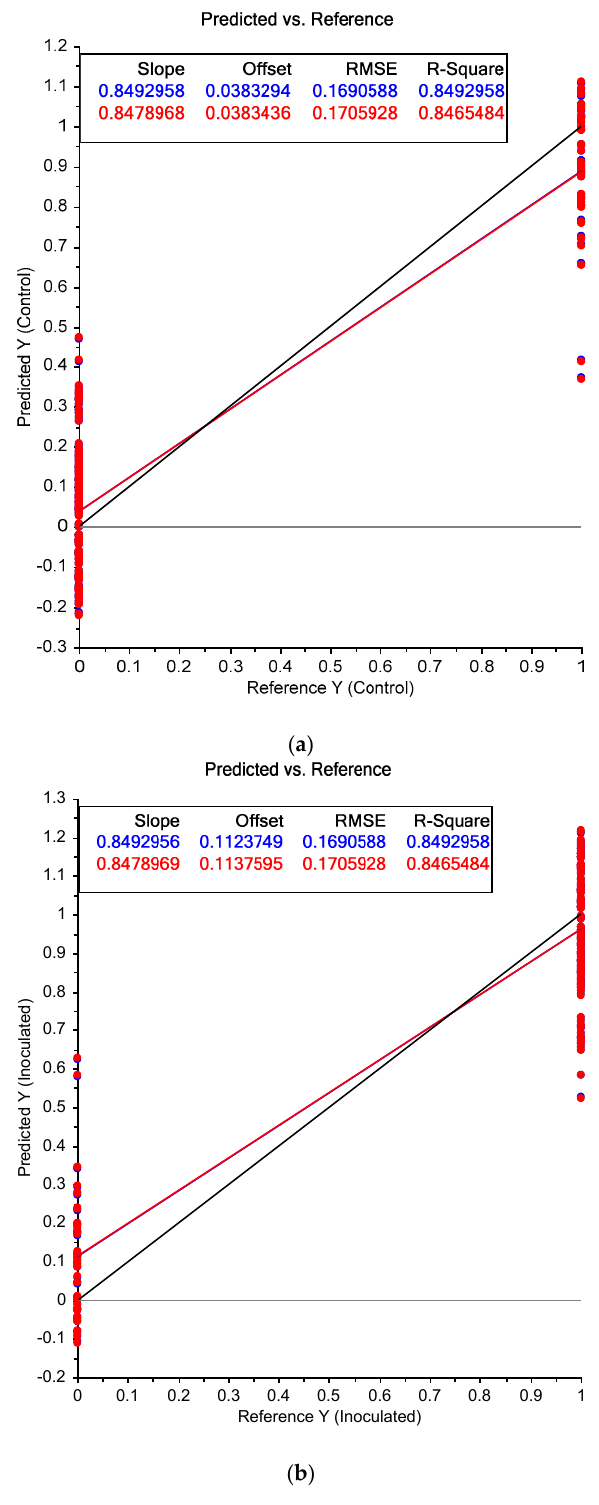
Figure 7. Regression plots for model using 2189 nm wavelength for ( a ) control and ( b ) inoculated samples at milk, dough and dent stages of maturity (with offset for control samples closer to target line) for categorical classification into control and inoculated sample groups. Red font and line represent validation data, blue font and line represent calibration data, black line represents the